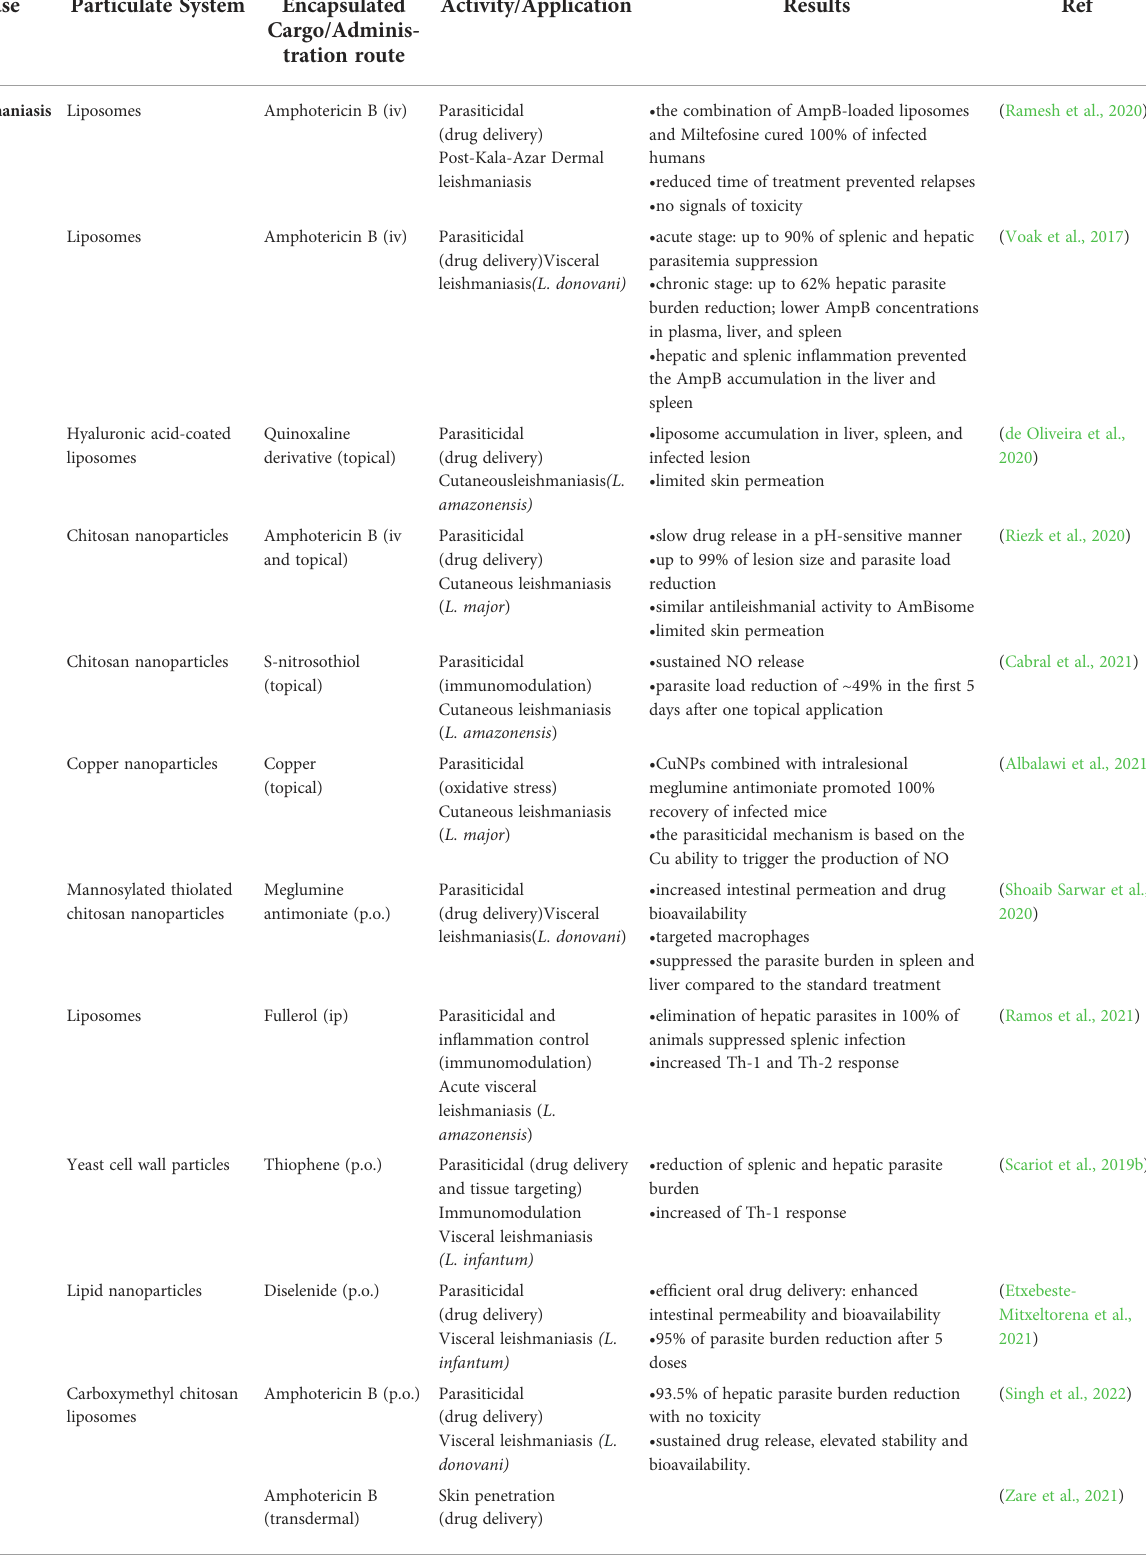
TABLE 1 Overview of the reviewed